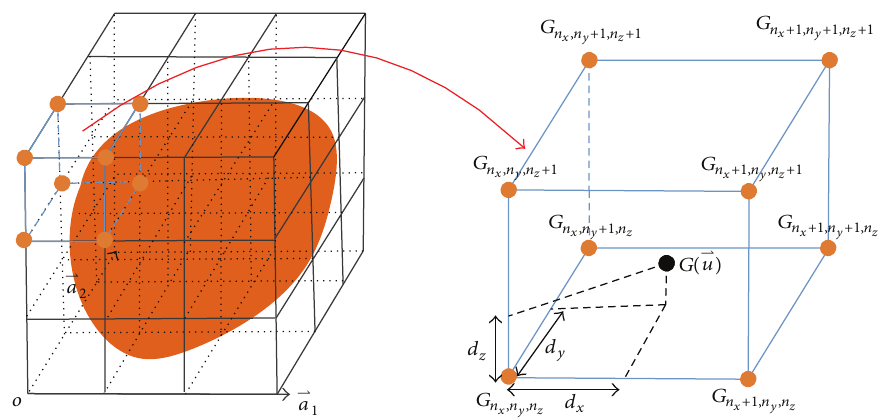
Figure 3: Depiction of trilinear interpolation of